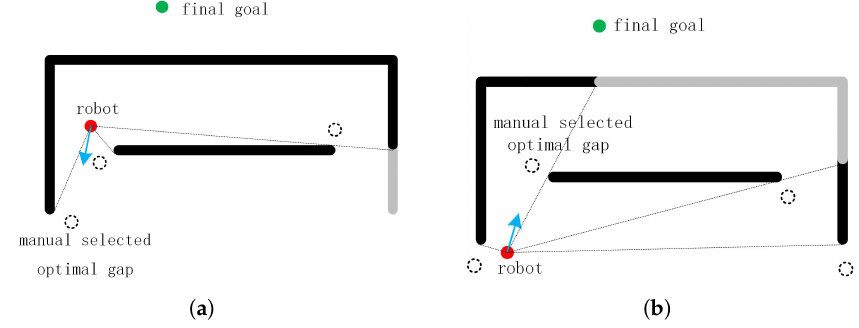
Figure 6. The identified gaps and manual selected direction of motion in two different